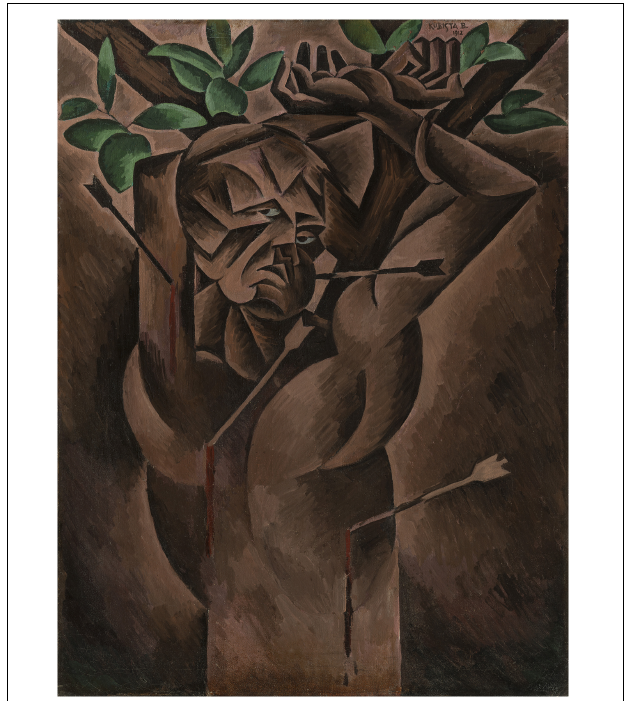
FIGURE 1 | Bohumil Kubišta, Saint Sebastian, 1912. Oil on canvas, 98 × 75 cm. Collection of National Gallery,